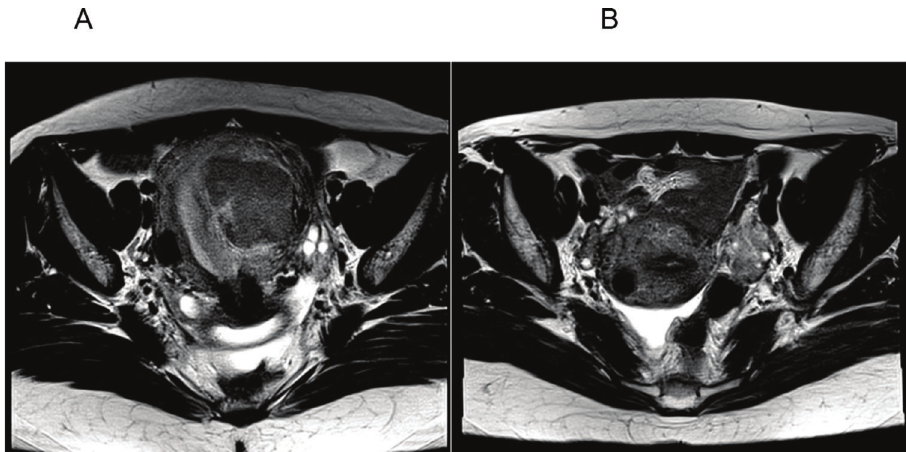
Figure 2 - A. Axial section of the pelvis before arterial embolization of myomas (AEM) showing a submucosal mass with an intramural component; B. Axial section of the pelvis 6 months after AEM showing absence of the previously characterized myometrial mass and a subserous residual fundic/cicatricial